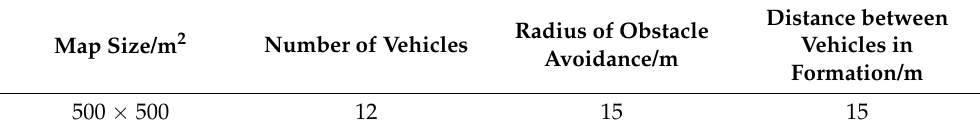
Table 2. Experimental environmental parameters under obstacle maps.